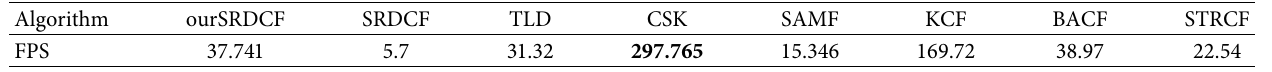
Table 1: Te number of picture frames processed by the algorithm per second. Algorithm